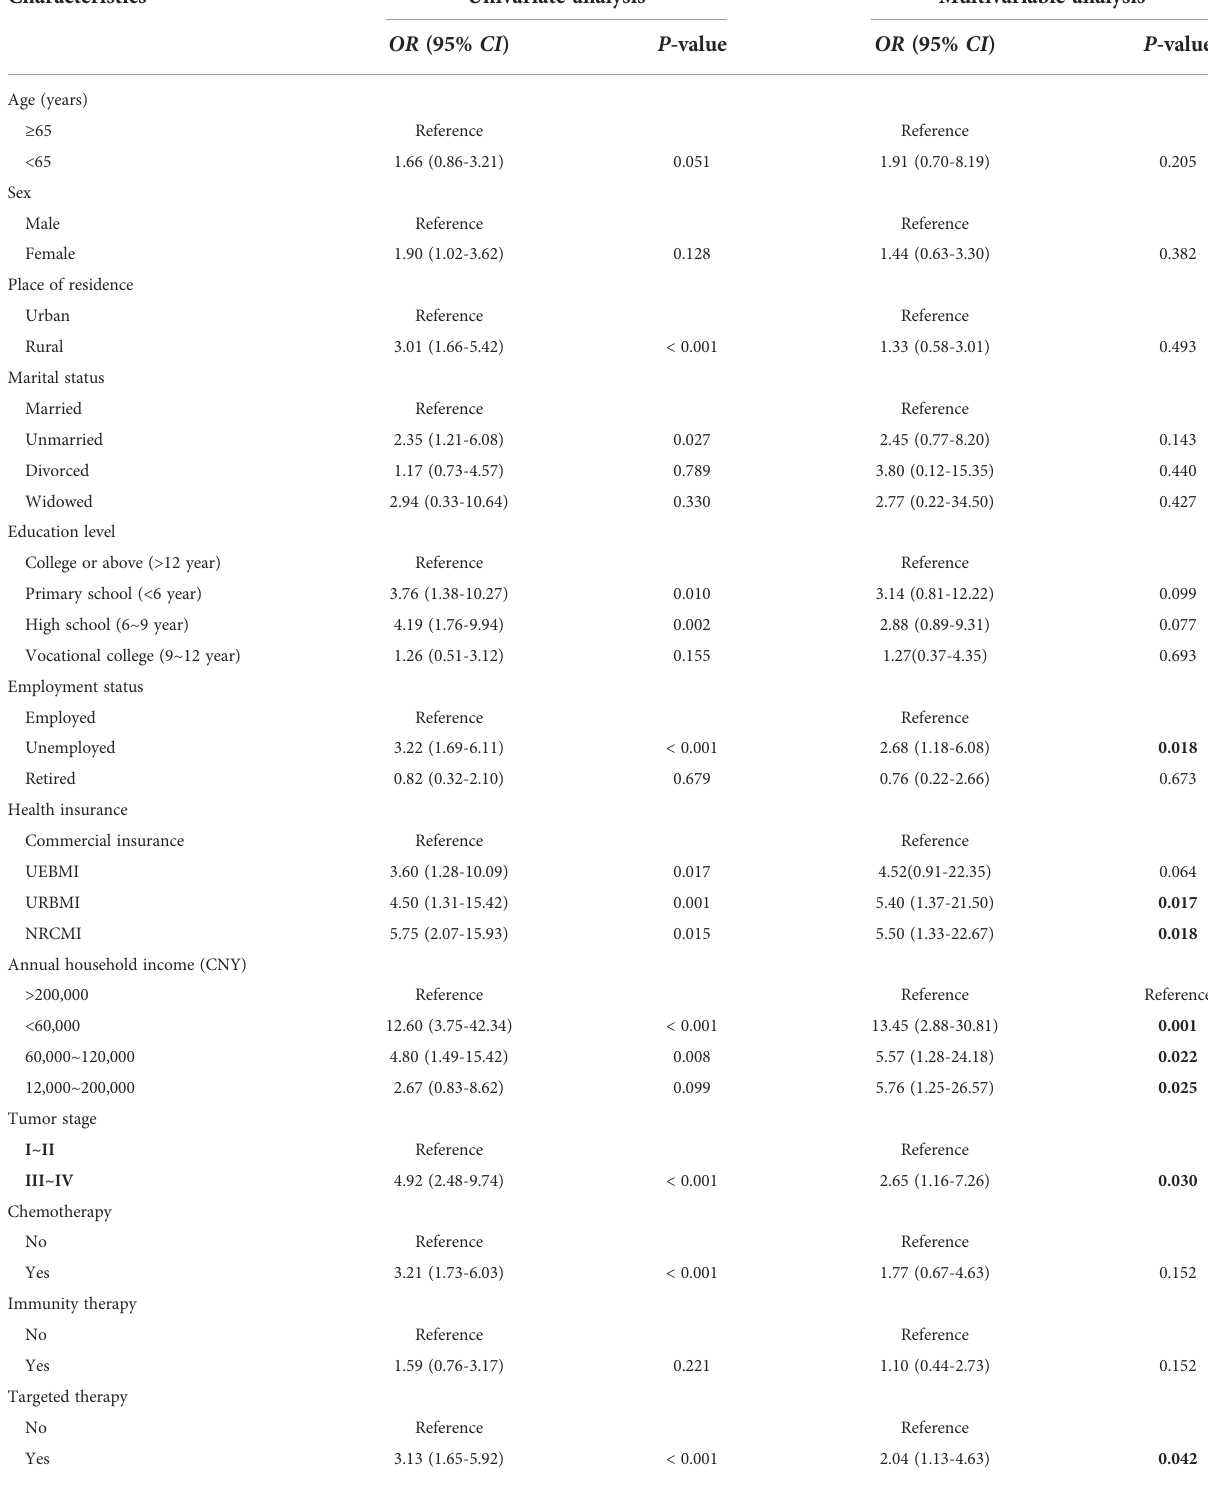
TABLE 3 Univariable and multivariable logistic regression models predicting the likelihood of self-reported fi nancial